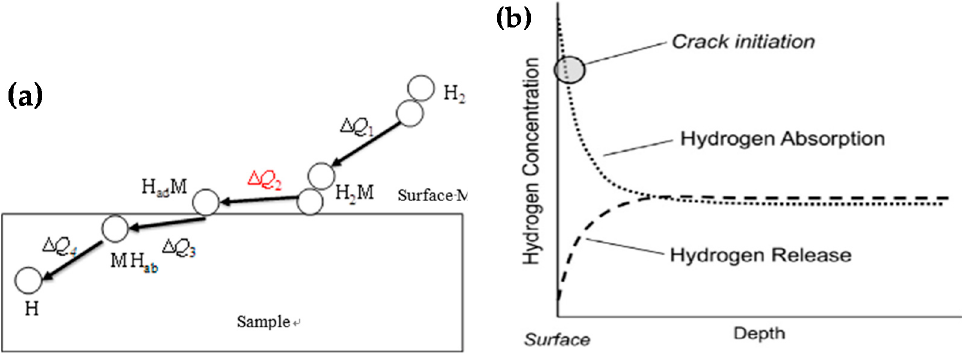
Figure 7. Schematic diagram for hydrogen entry from air to sample ( a ) and the change in the in-depth profile of hydrogen concentration in high strength steel under atmospheric corrosion ( b ) [41].